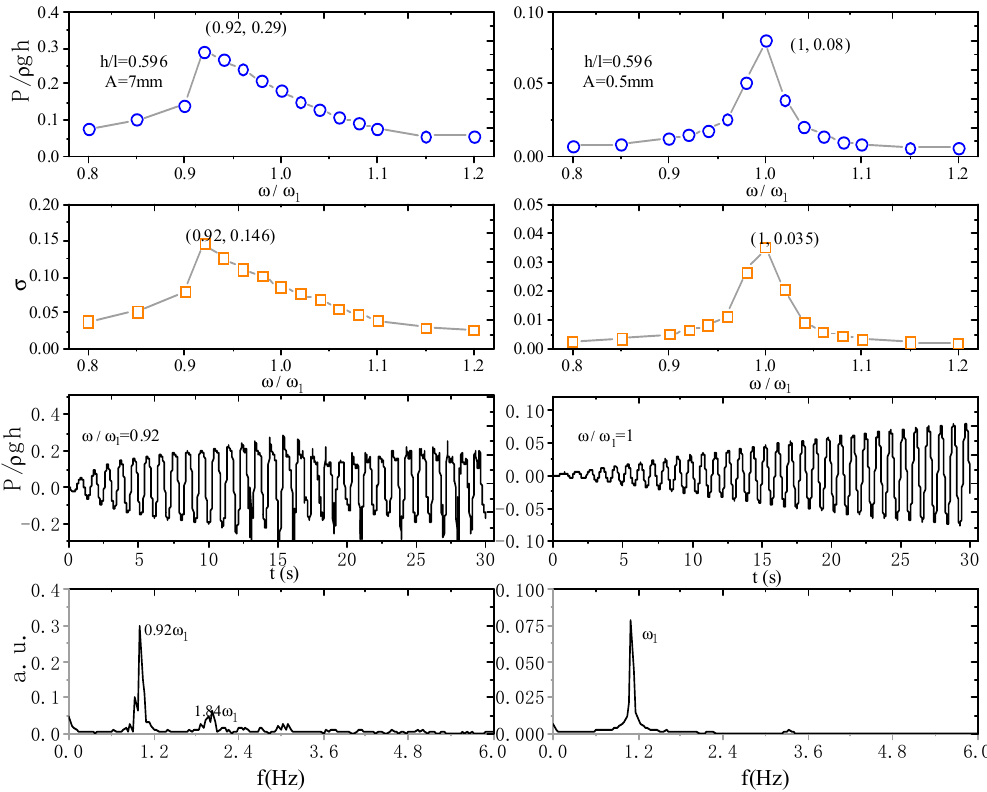
Figure 18. The effects of wave breaking on deepwater sloshing.